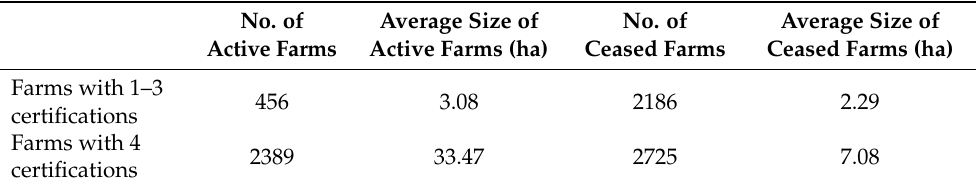
Table 5. Average size of active and ceased farms, in relation to the number of